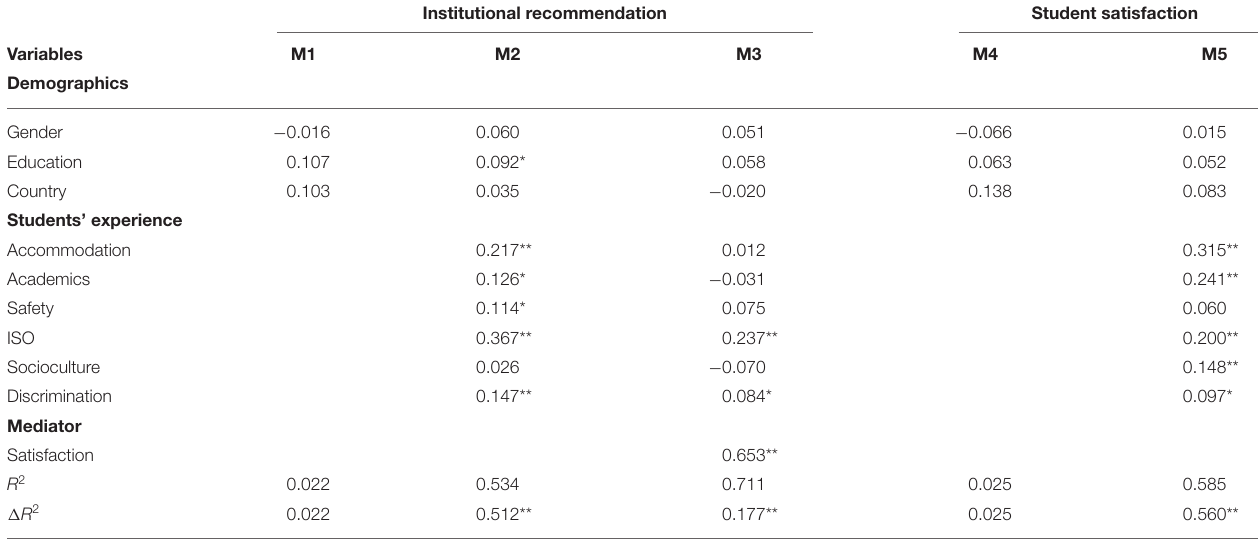
TABLE 3 | Regression results.